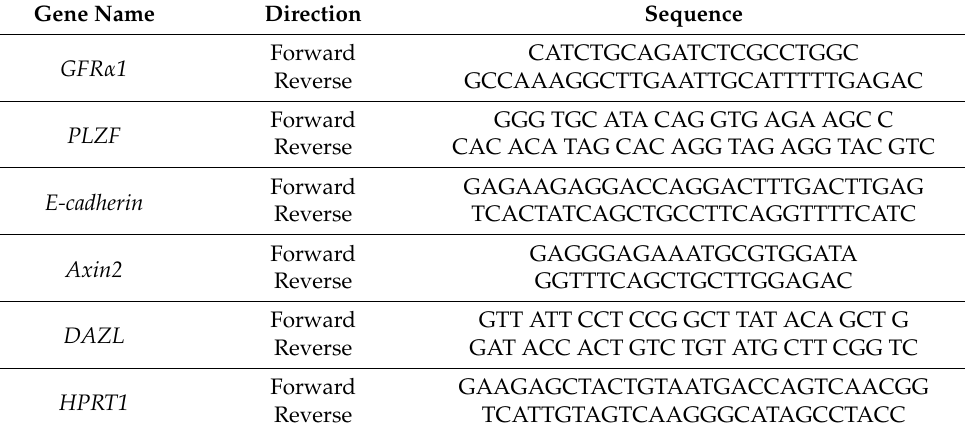
Table 3. Primer sequences used for